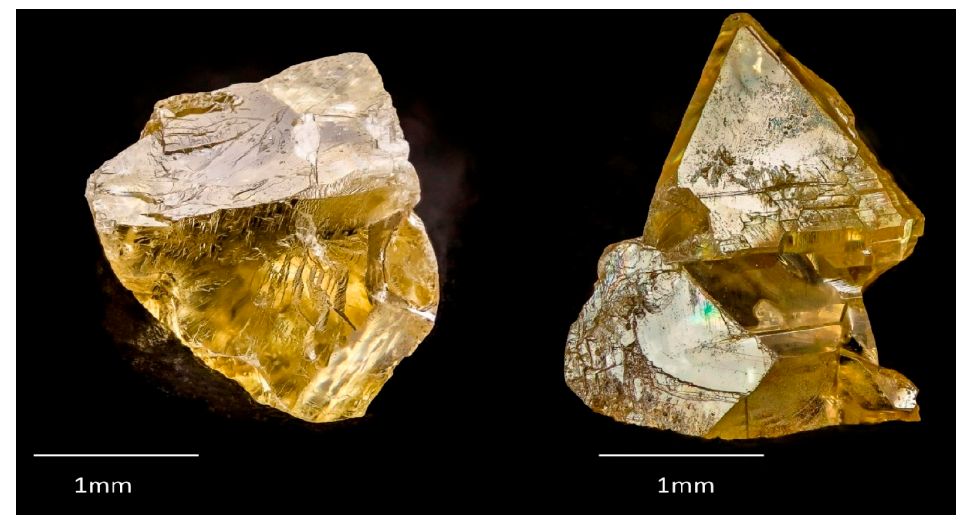
Figure 33. Microphotos of the synthetic sphalerite crystals with admixtures of Ag and In, synthesised